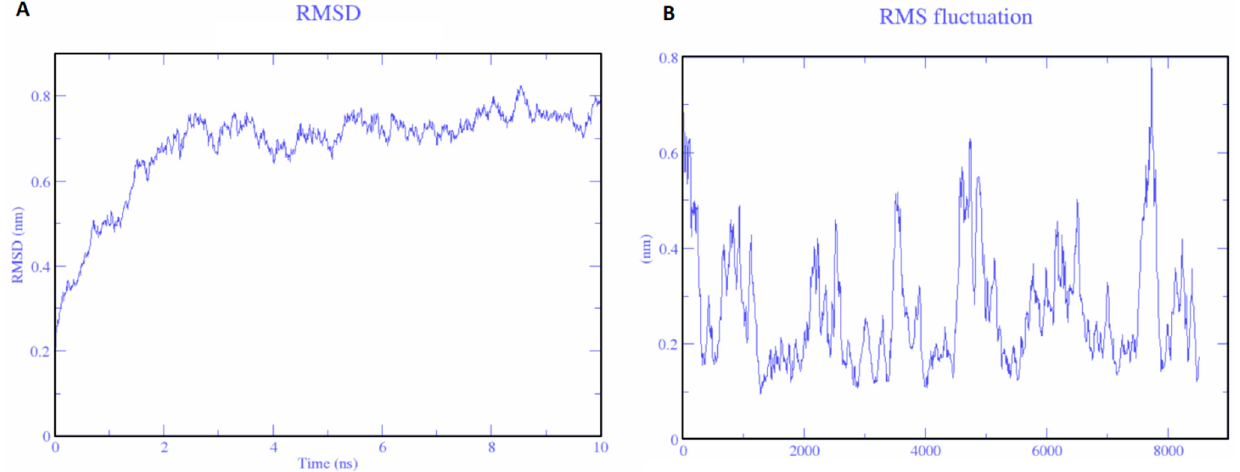
Figure 4. Molecular dynamics simulations of the vaccine candidates. ( A ) RMSD; RMSD levels off to 0.5 (Vu), this shows the stability of the vaccine construct. ( B ) RMSF; RMSF-Root Mean Square Fluctuation plot, heights show the high-flexibility regions.